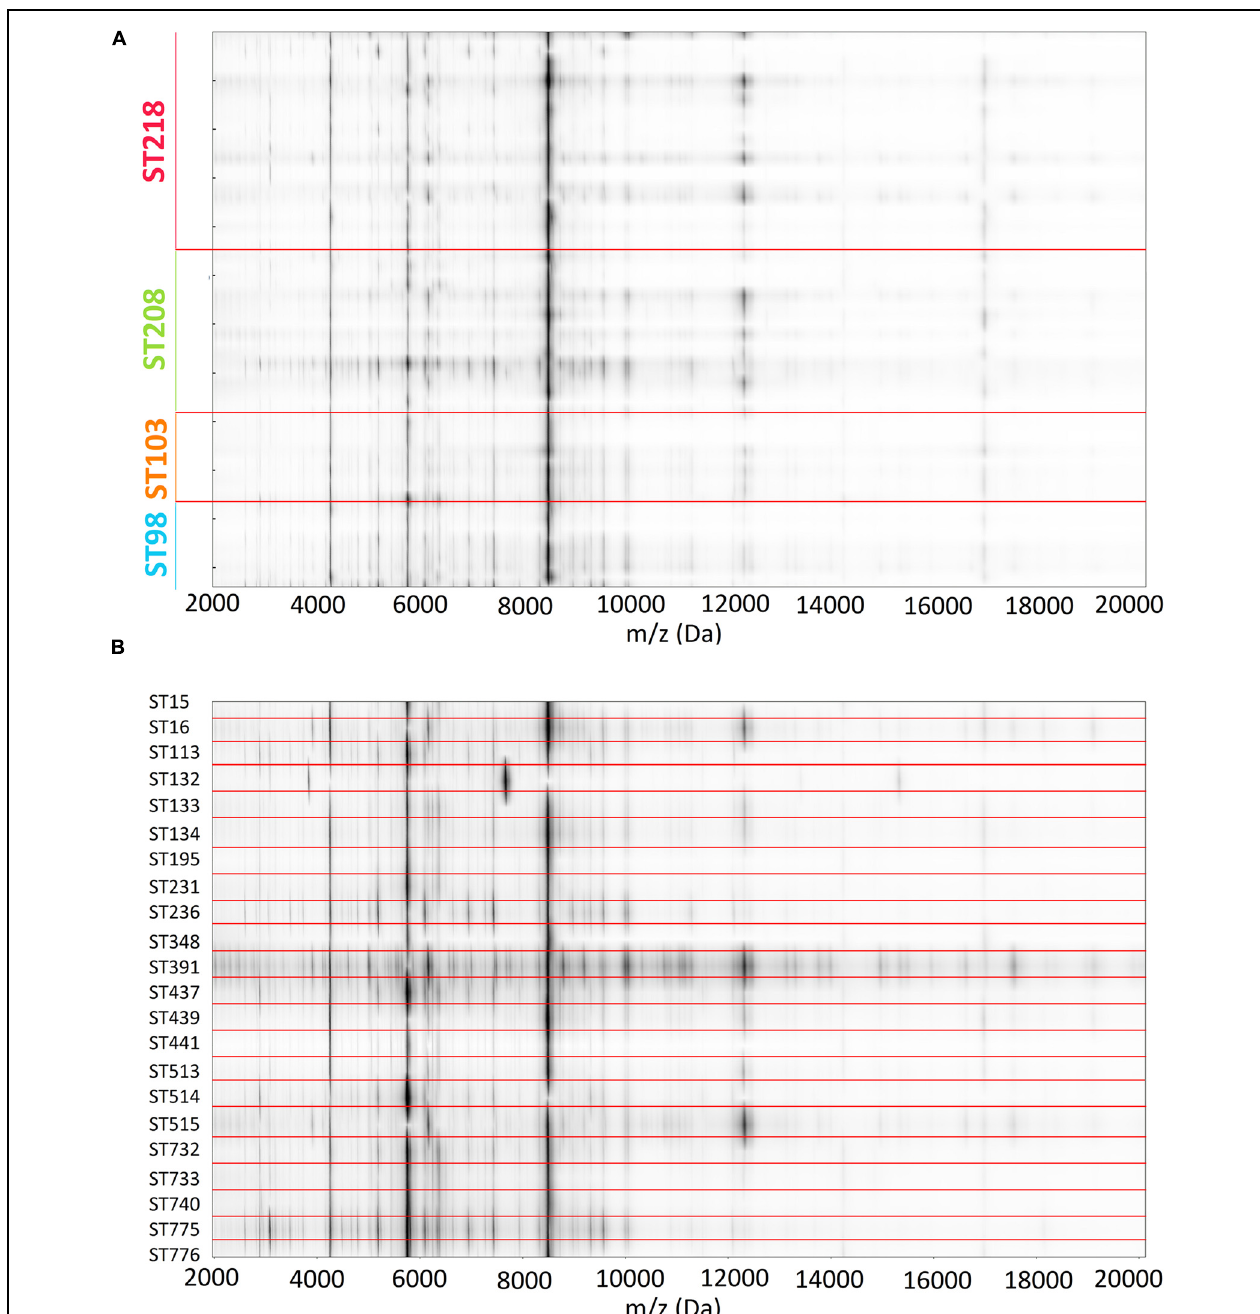
FIGURE 2 | Pseudo gel view representation obtained from the average mass spectra of each Acinetobacter baumannii isolate of ST98, ST103, ST208, and ST218 (A) and of A. baumannii isolates of the international collection (B).